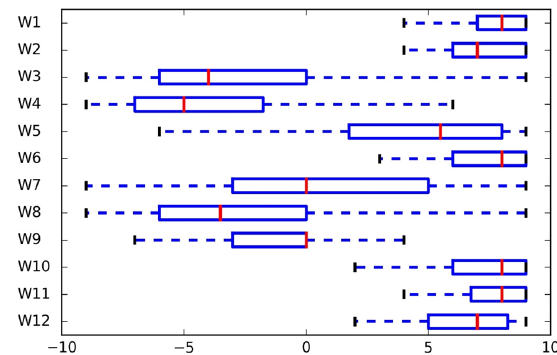
Figure 1. Views on wind energy by Kenyan (semi-)experts. In the boxplots the median is represented by a red line, the first and third quartiles form the edges of the box and the whiskers extend from the hinges of the box to the 5 th and 95 th percentiles.